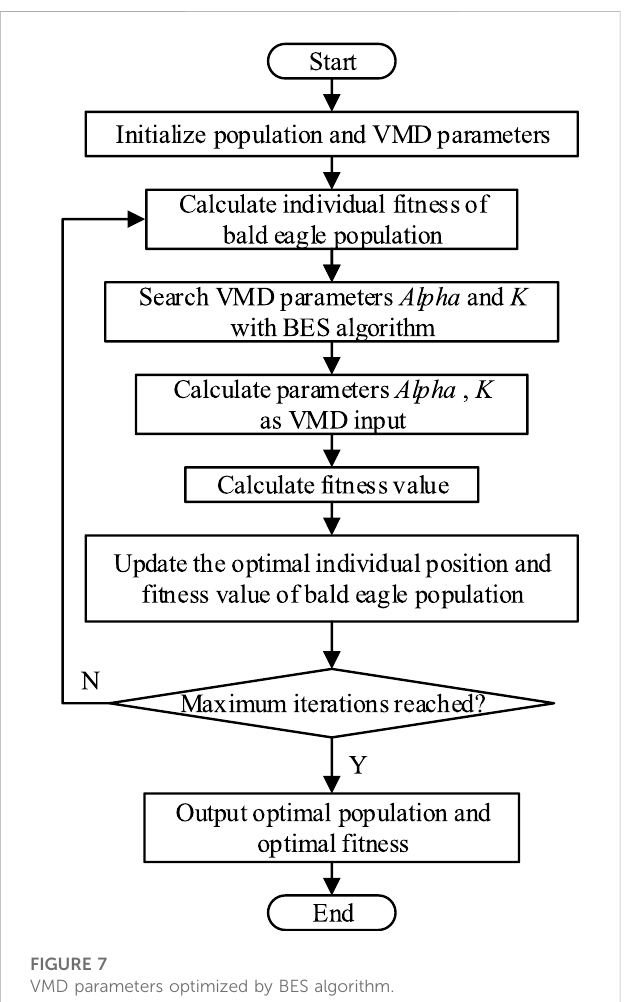
FIGURE 7 VMD parameters optimized by BES algorithm.